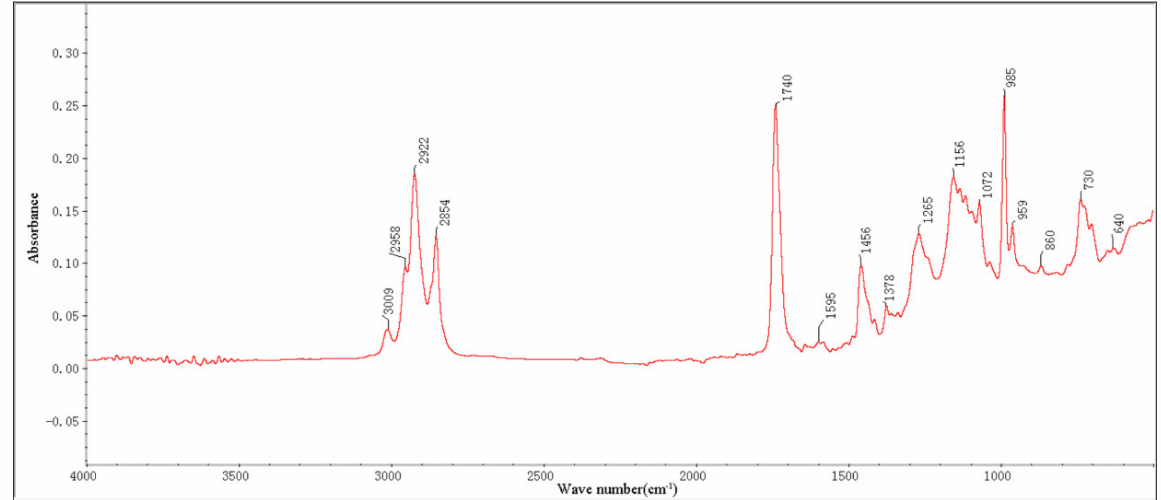
Figure 12. Infrared spectrum of tung oil composite regenerating